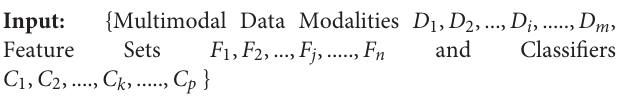
Algorithm 1 Multimodal Data–Driven Ensemble (MMDD- Ensemble)